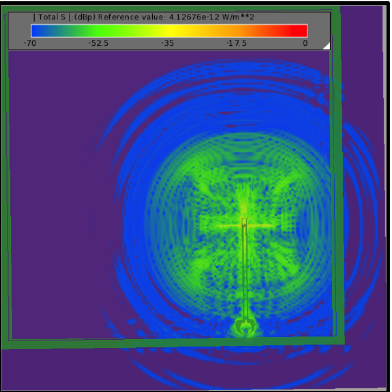
Figure 14. Poynting (cid:126) S